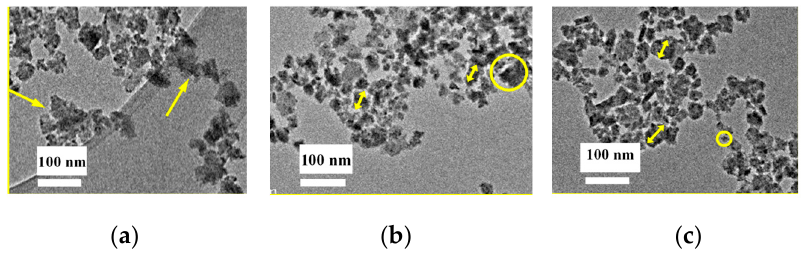
Figure 5. Transmission electron microscopy images of the ( a ) Ag 2 Se, ( b ) Ga 2 Se 3 , and ( c ) In 2 Se 3 nanoparticle inks.